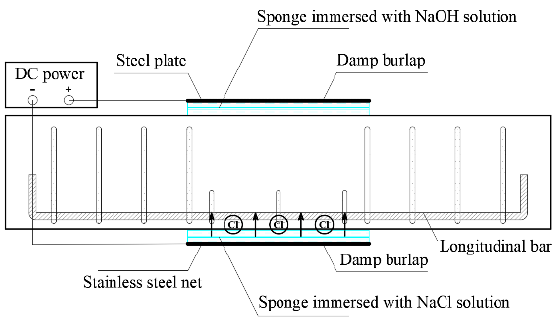
Figure 5. Electro-osmosis test.